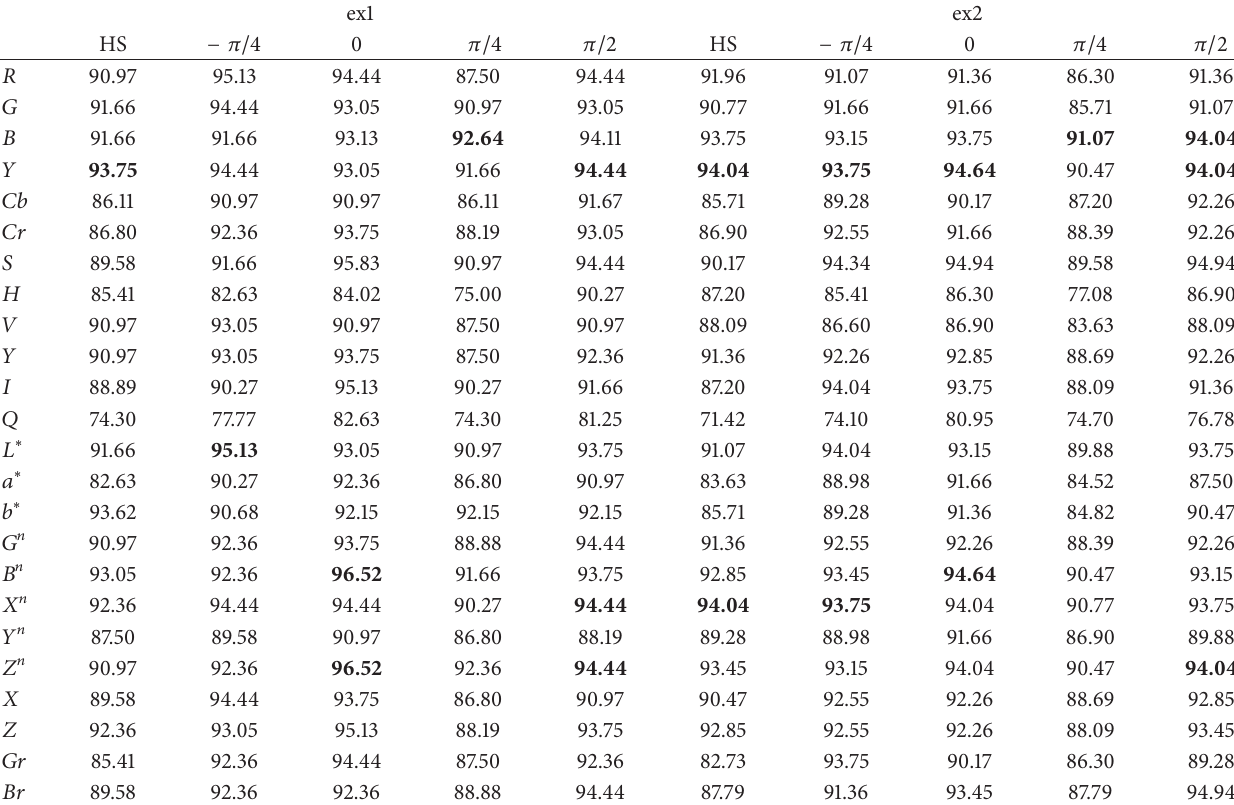
Table 1: Performance comparison in color component images of LCSPT-ELM face recognition algorithm: the AR